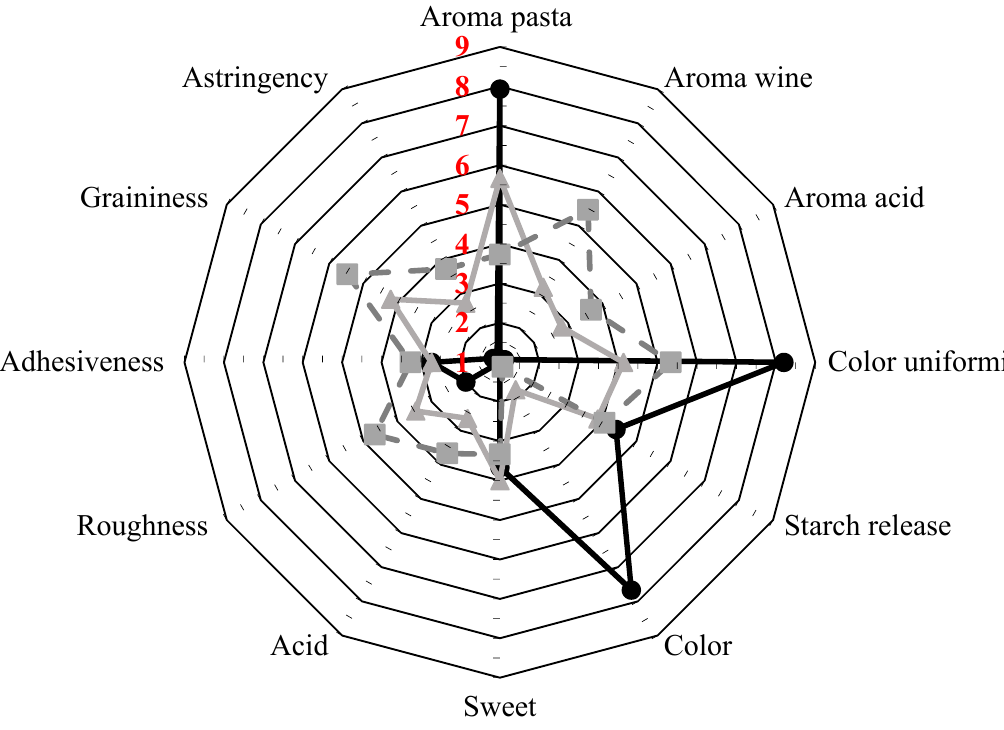
Figure 2. Sensory scores of quality attributes of pasta fortified with grape pomace at different addition levels (GP0 black solid line; GP5 solid gray line; GP10 dashed gray line).